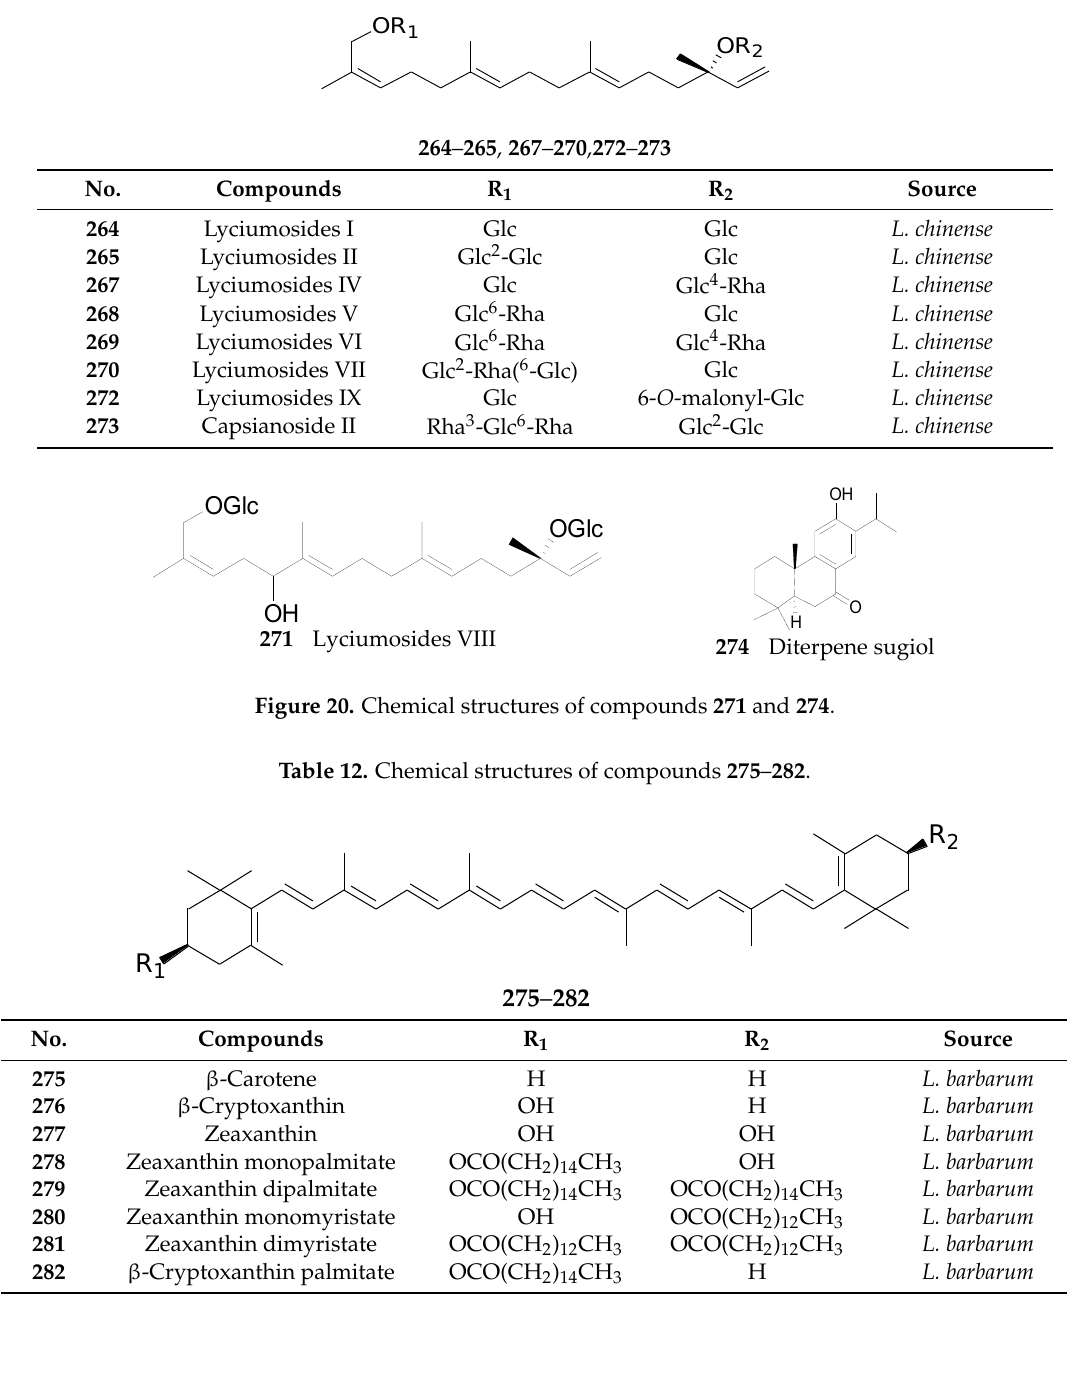
Figure 19. Chemical structures of compounds 252 – 263 , 266 . Table 11. Chemical structures of compounds 264 – 265 , 267 – 270 and 272 – 273 .